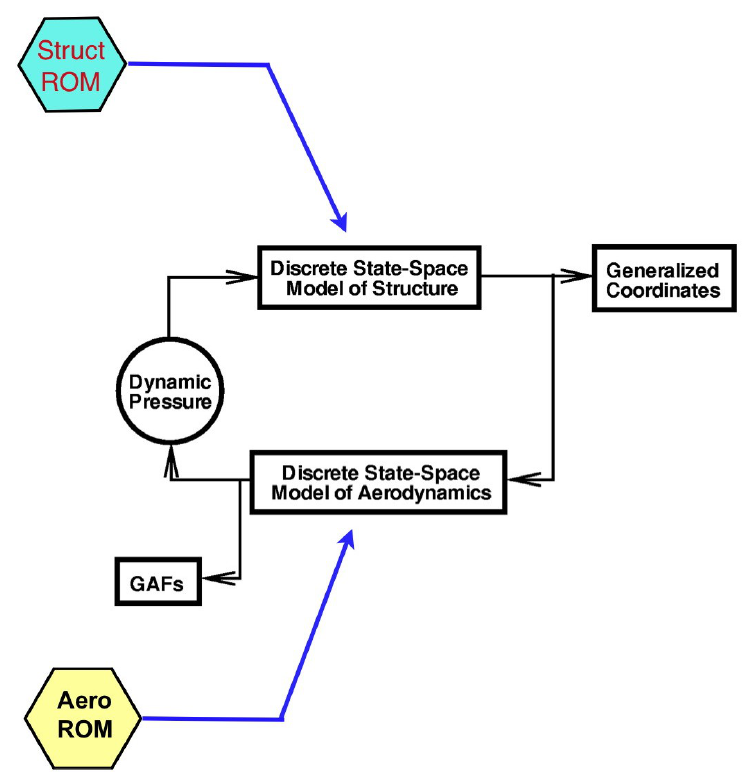
Figure 4. Process for generation of an aeroelastic simulation ROM consisting of an unsteady aerodynamic ROM and a structural dynamic state-space